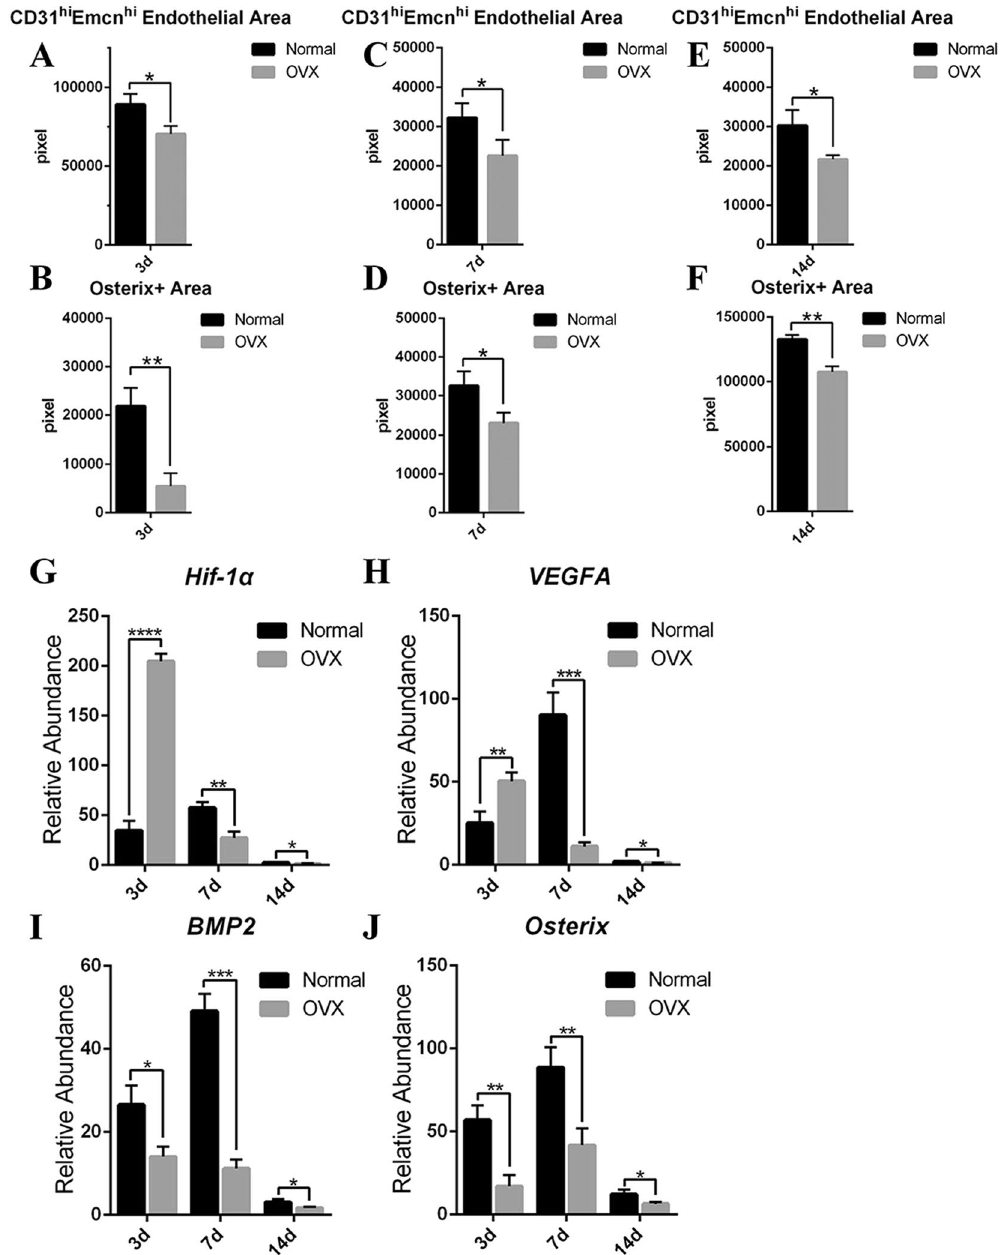
Figure 6. ( A–F ) Statistical comparisons of CD31hiEmcnhi vessels and the area of osterix-staining positive between normal and OVX rats during the repair process. Under osteoporotic conditions, the amounts of CD31hiEmcnhi vessels and osterix + cells were significantly reduced at 3, 7 and 14 days post-injury. ( G–J ) Statistical comparisons of the transcriptional levels of Hif - 1 α , VEGFA , BMP2 and Osterix . The transcriptions of Hif - 1 α and VEGFA at 3 days post-injury in OVX rats were significantly higher than those in normal rats. * P < 0.05; ** P < 0.01; *** P < 0.001, n =